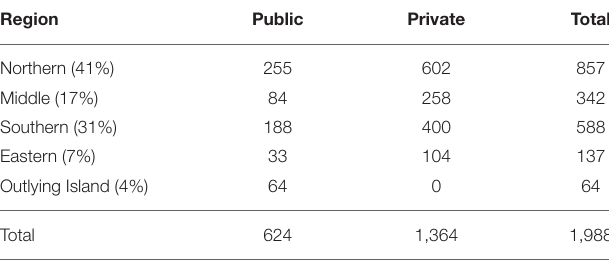
TABLE 2 | Dispersion of sample across regions and sectors.